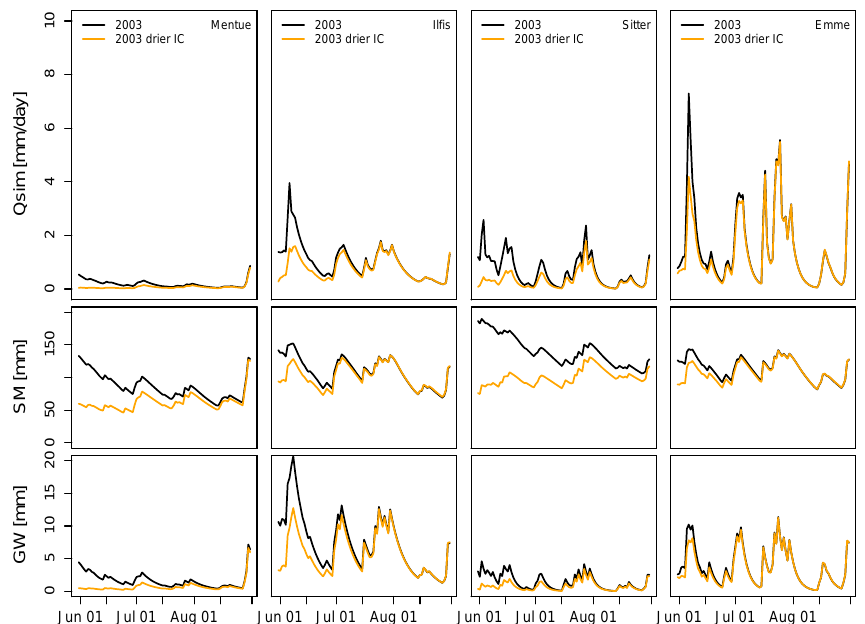
Figure 5. Simulation (median of 100 simulations) of the summer drought 2003, original and with drier initial conditions